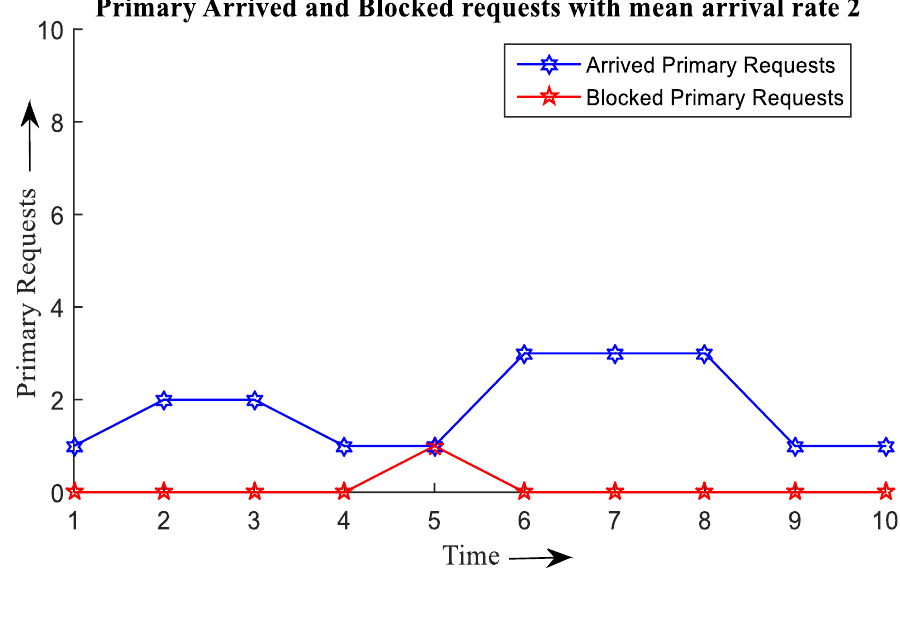
Figure 6. Primary arrived and blocked requests ( 𝜆 = 2 )